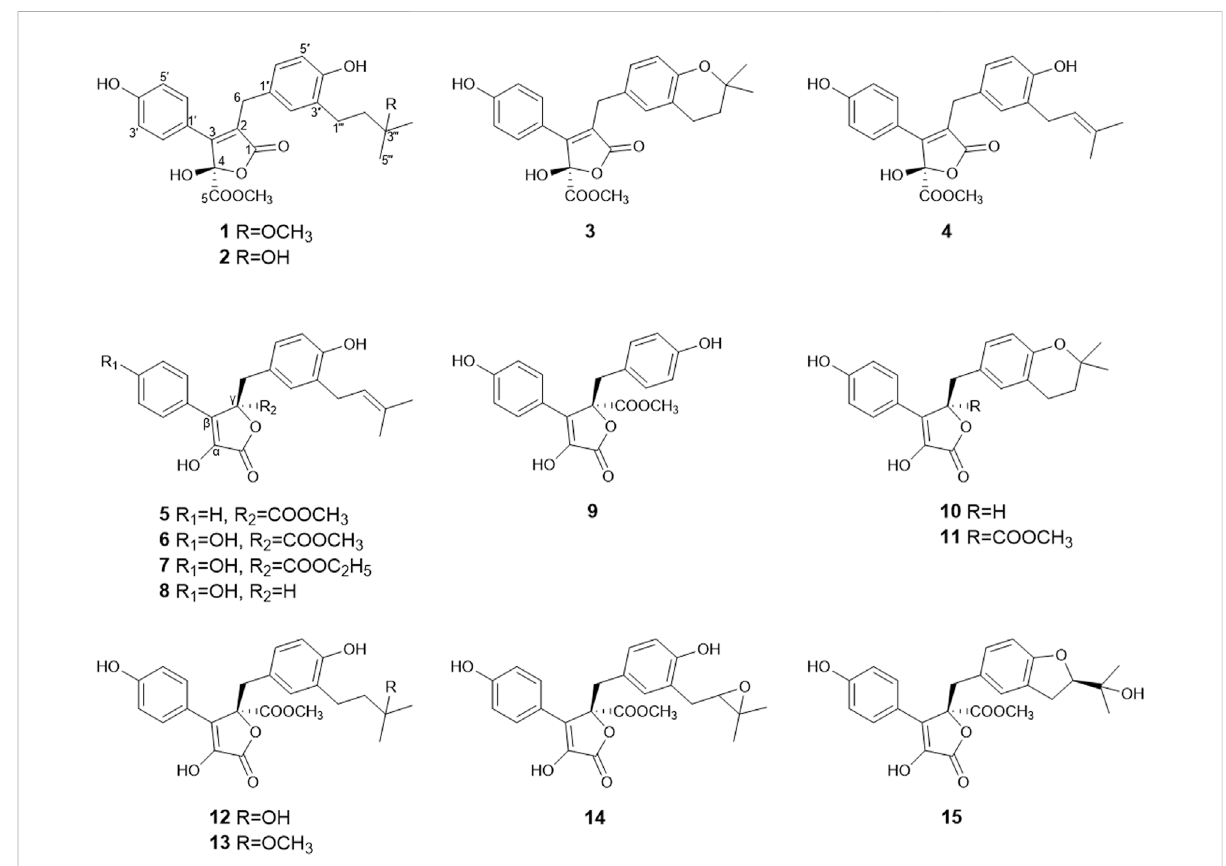
FIGURE 2 Chemical structures of compounds 1 – 15 .